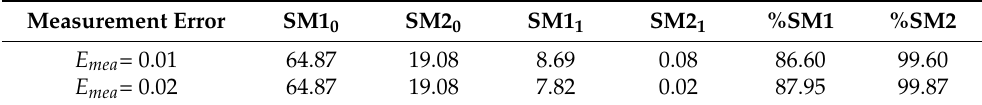
values. (cid:3040)(cid:3032)(cid:3028)